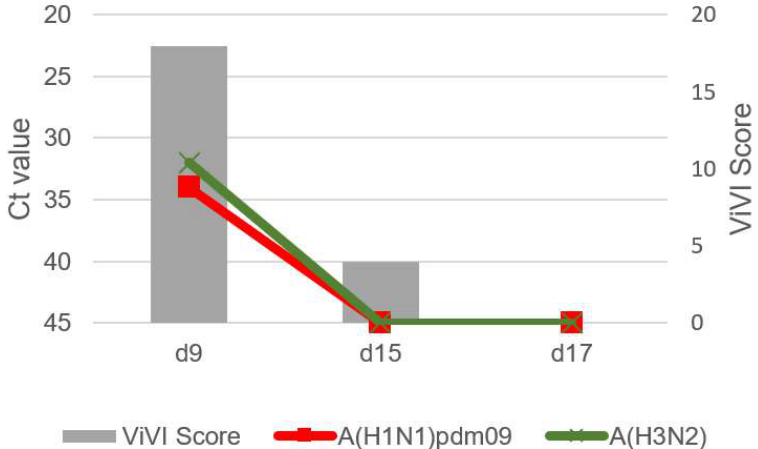
Figure 4. Patient 1 presents with influenza A/A virus dual infection. Virus load (left inverted vertical axis) as approximated by Ct values correlated with ViVI Scores (right vertical axis) reflecting increasing disease severity with increasing values.